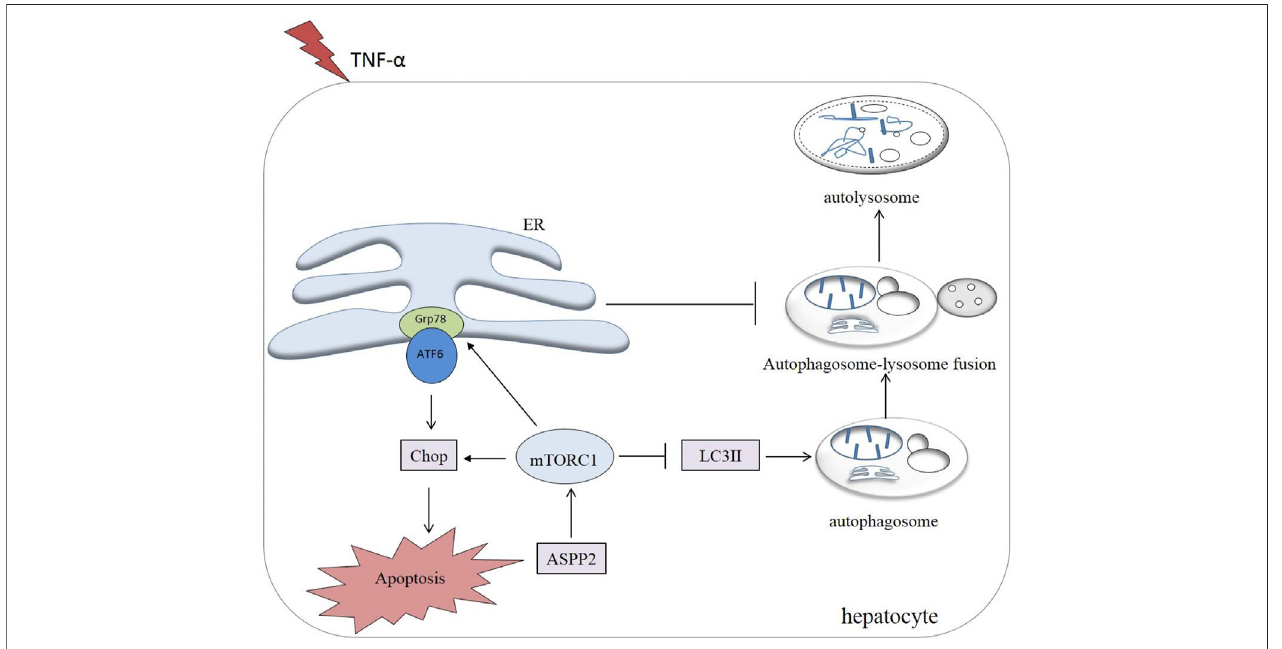
FIGURE8| Aworkingmodel illustrating theroleofASPP2 inthecross-talk betweenERS-apoptosisand autophagy.ASPP2 wasactivated inthehepatocyte injury induced by TNF- α . ASPP2 upregulated mTORC1, inhibited autophagy, and promoted ERS-apoptosis through Grp78 and Chop. mTORC1, downsteam of ASPP2, switched autophagy to ERS-apoptosis of hepatocyte in response to TNF- α . ERS also inhibited autophagy by suppressing the autophagosome-lysosome